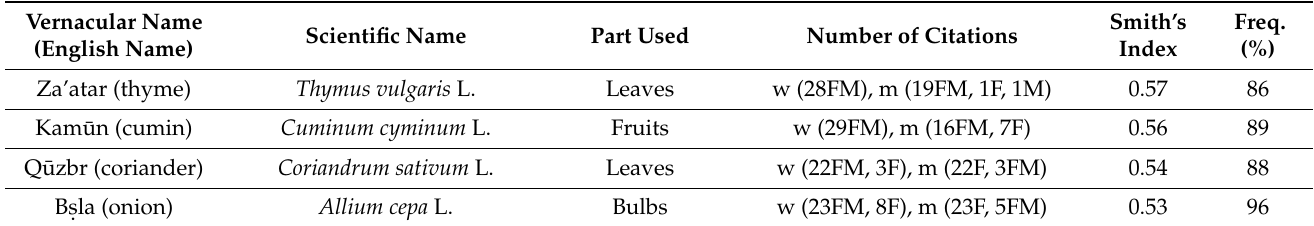
Table 2. Items cited by more than five participants, ordered according to the Smith’s saliency index. Number of citations indicates the number of participants that mentioned food (F), medicine (M), or food and medicine (FM) uses for each item, disaggregated by gender (w = women, m = men). Freq. indicates the frequency of citation in